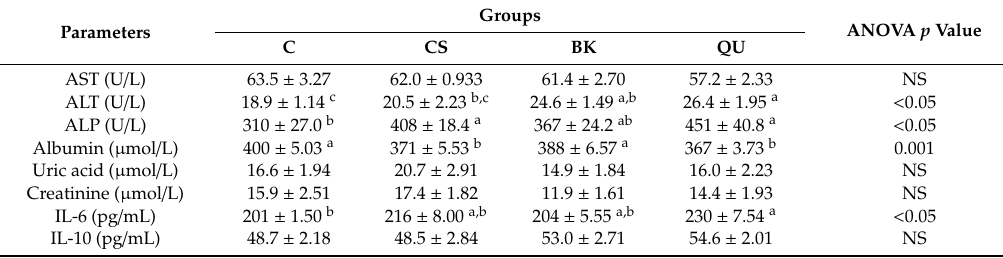
Table 6. Inflammatory indicators in the plasma of rats fed experimental diets. Parameters